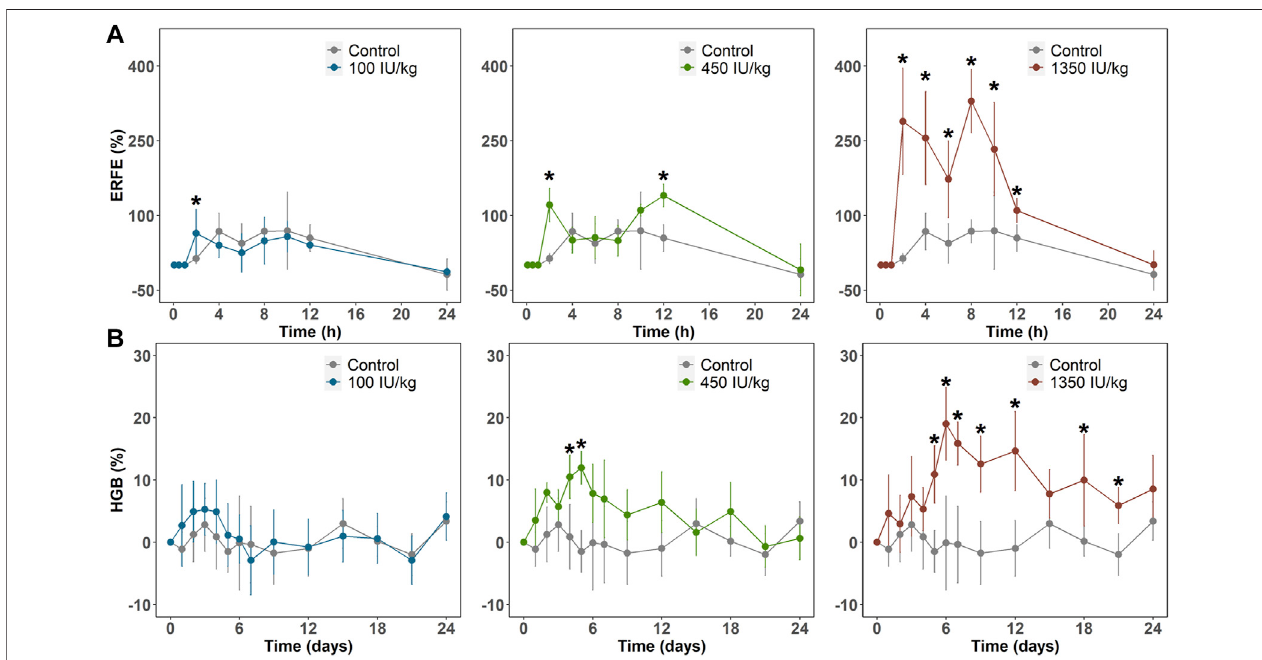
FIGURE1|(A) ERFEresponse (B) andHGBresponseafterasingleIVdose(100,450,or1350 IU/kg)ofrHuEPO.ERFEandHGBconcentrationswerenormalized bybaselinevaluesandpresentedaspercentageincreases ( Value − Baseline × 100 ) .Dataarepresentedasmeans±SD( n =3ateachtimepointforERFEresponse; n =9for Baseline HGB response; * p < 0.05, comparison of ERFE in treatment group versus control group at each time point). SD, standard deviation.